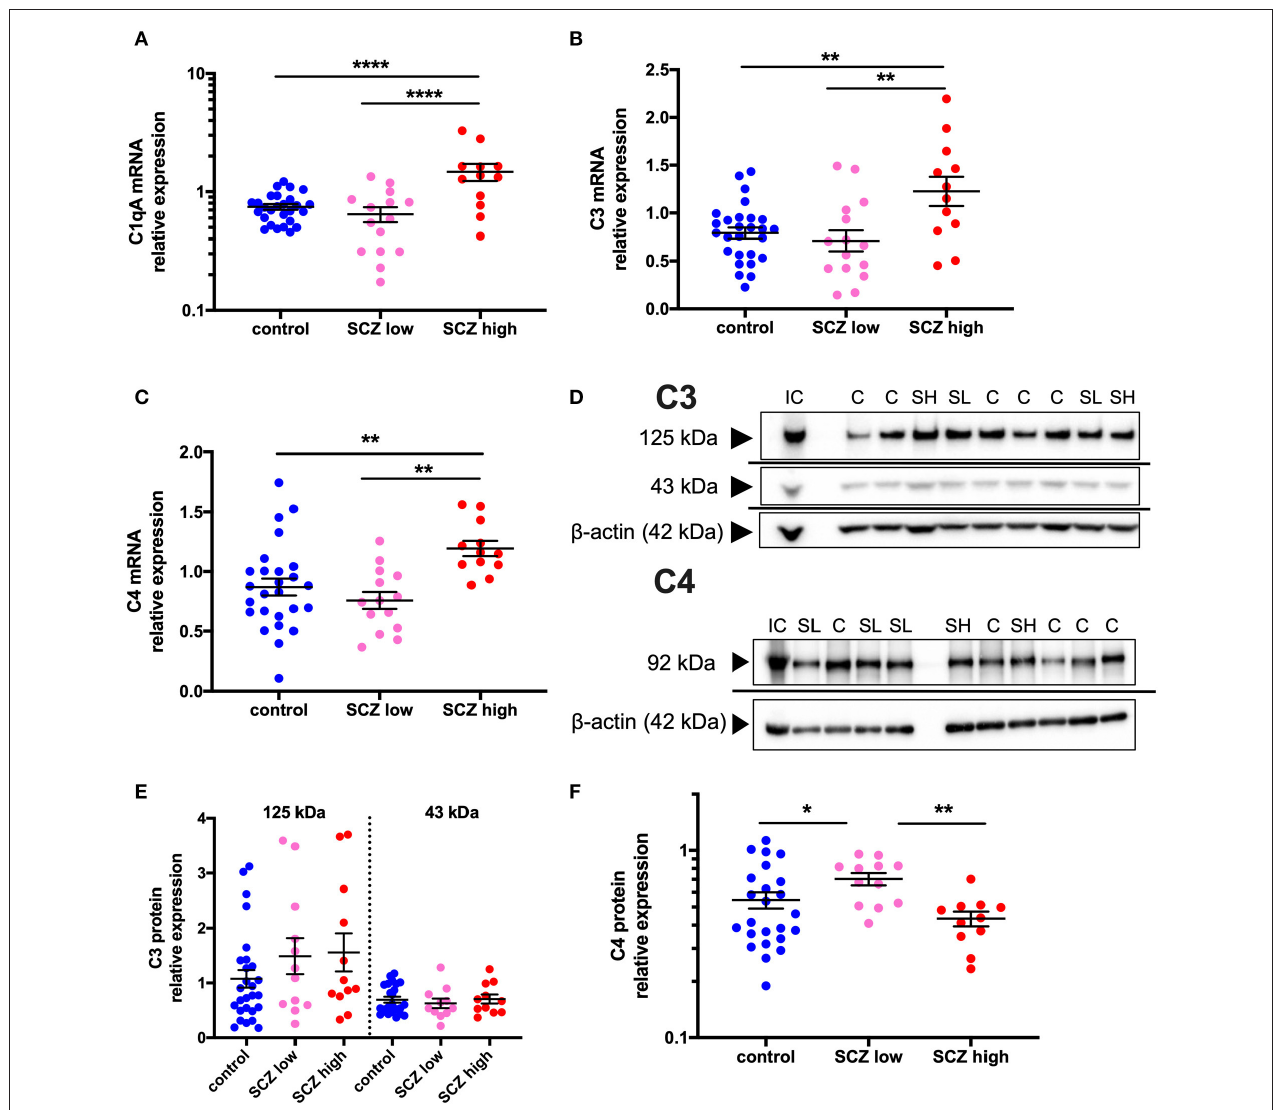
FIGURE 5 | Complement pathway-related transcripts are increased and C4 protein is decreased in the midbrain in schizophrenia cases with a high inflammatory biotype. (A) Gene expression of the complement cascade initiator molecule, C1qA, was elevated when analyzed by inflammatory subgroup ( F = 11.68, df = 50,2, p < 0.0001). Gene expression of the complement cascade molecules C3 (B) ( F = 5.51, df = 50,2, p = 0.007) and C4 (C) ( F = 6.88, df = 49,2, p = 0.002) were also both elevated in the schizophrenia/high inflammatory subgroup compared to the control group and the low inflammatory/schizophrenia subgroup. (D) A C4 protein band was detected at 92 kDa and C3 protein bands were detected at 125 and 43 kDa in human midbrain. β -actin ( ∼ 42 kDa) was detected in all samples and was used as a normalizing control. (E) The C3 protein bands were unchanged when analyzed by inflammatory subgroup (all F < 1.30, df = 42/43,2, p > 0.05). (F) C4 protein expression was changed according to inflammatory subgroup ( F = 4.59, df = 44,2, p = 0.015) but C4 protein expression was increased in the low inflammatory/schizophrenia subgroup compared to both the high inflammatory/schizophrenia subgroup and the control group. Data are mean ± SEM, * p < 0.05, ** p < 0.01, **** p < 0.0001. C, control; SL, low inflammatory schizophrenia; SH, high inflammatory schizophrenia; IC, internal control.